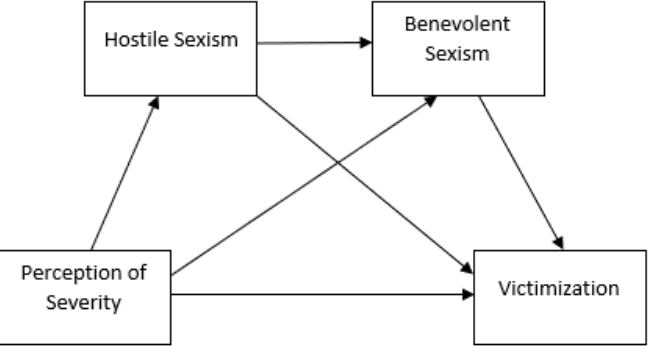
Figure 1. Serial mediation model 6.